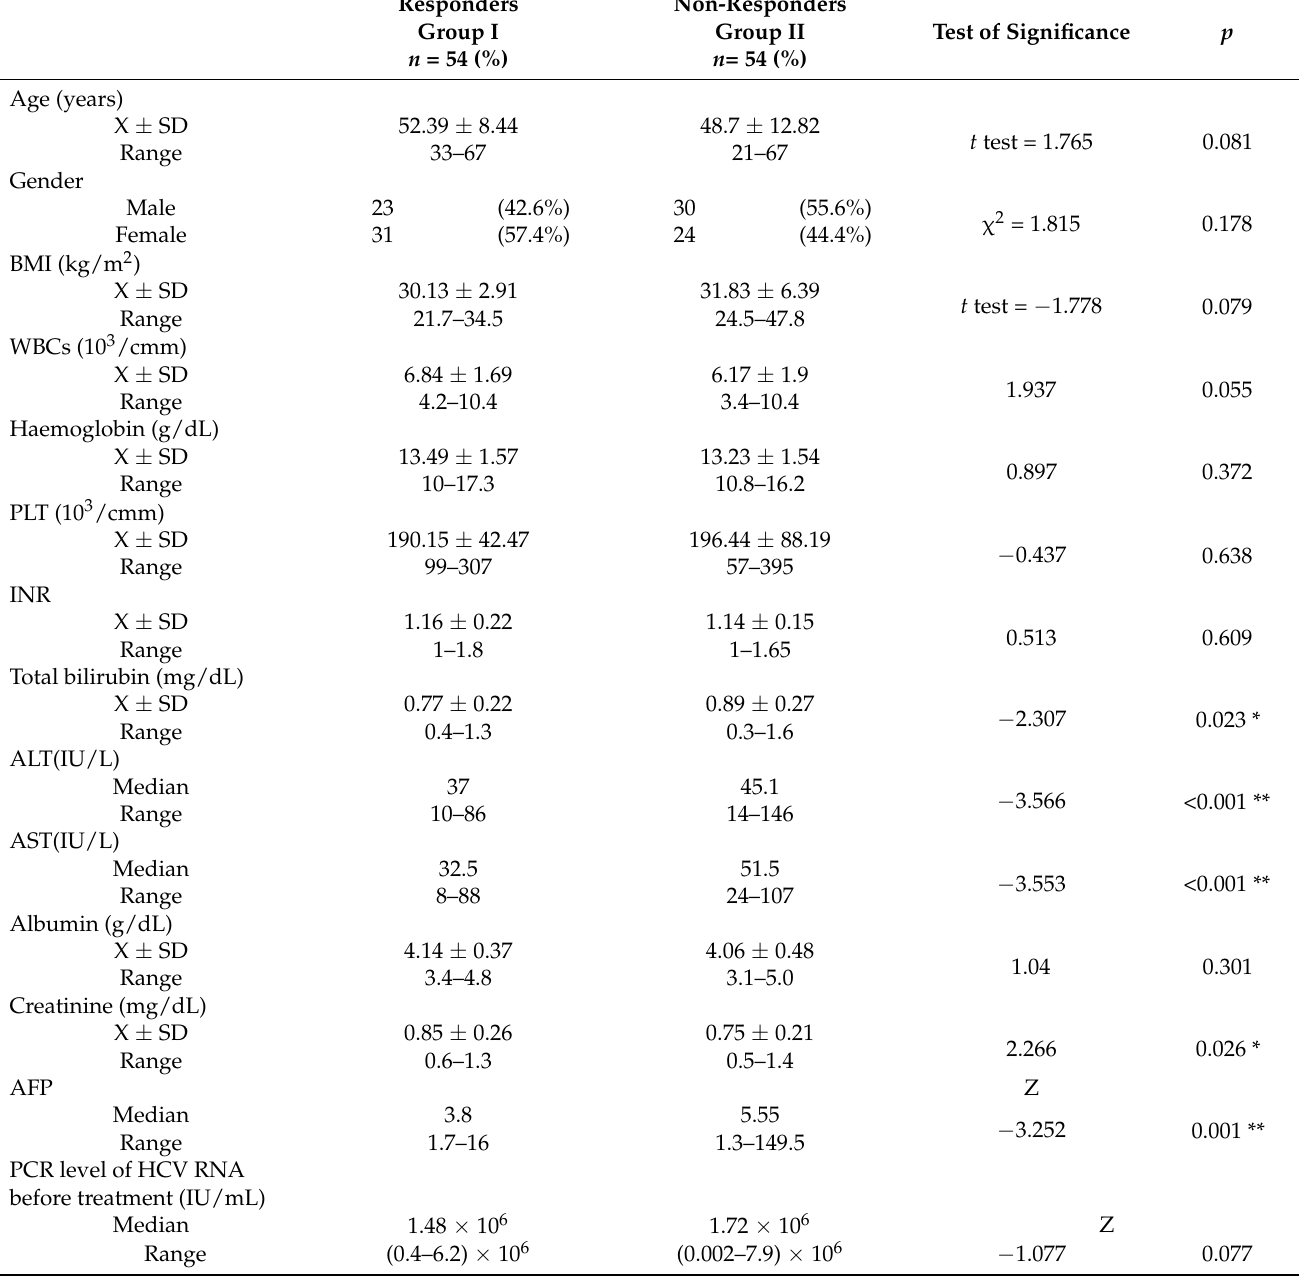
Table 1. Demographics and laboratory variable characteristics of the studied